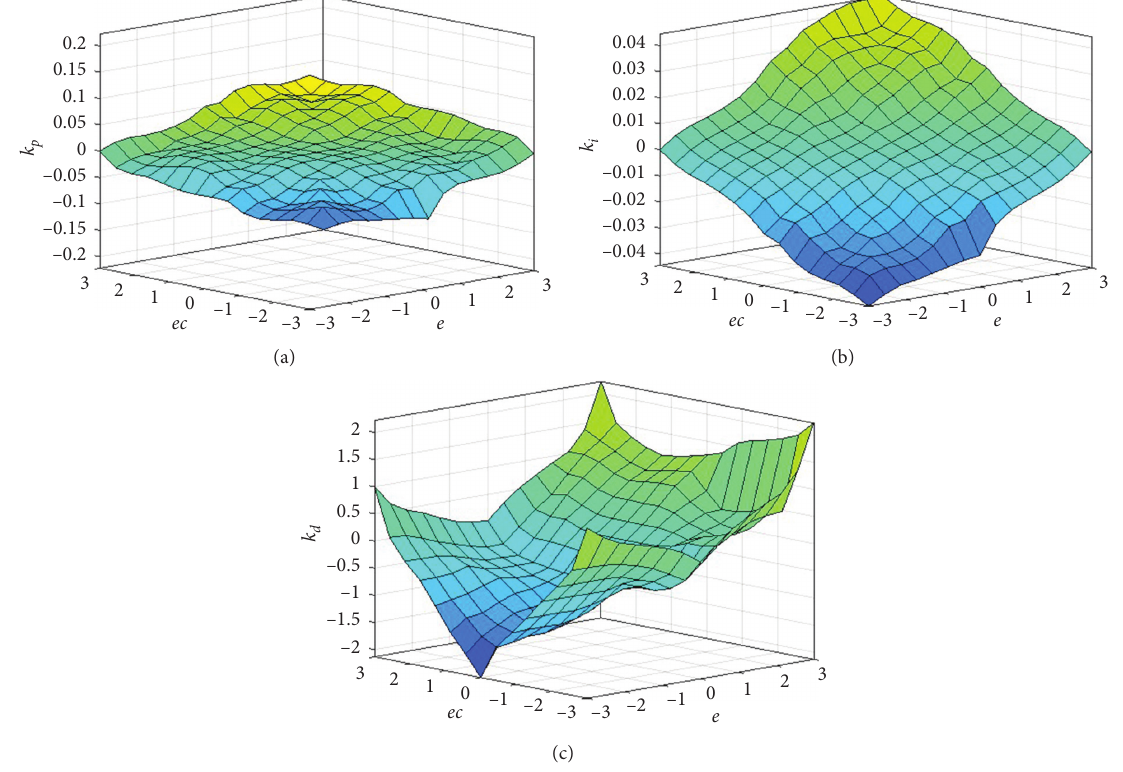
Figure 6: Surface schematic representations for K